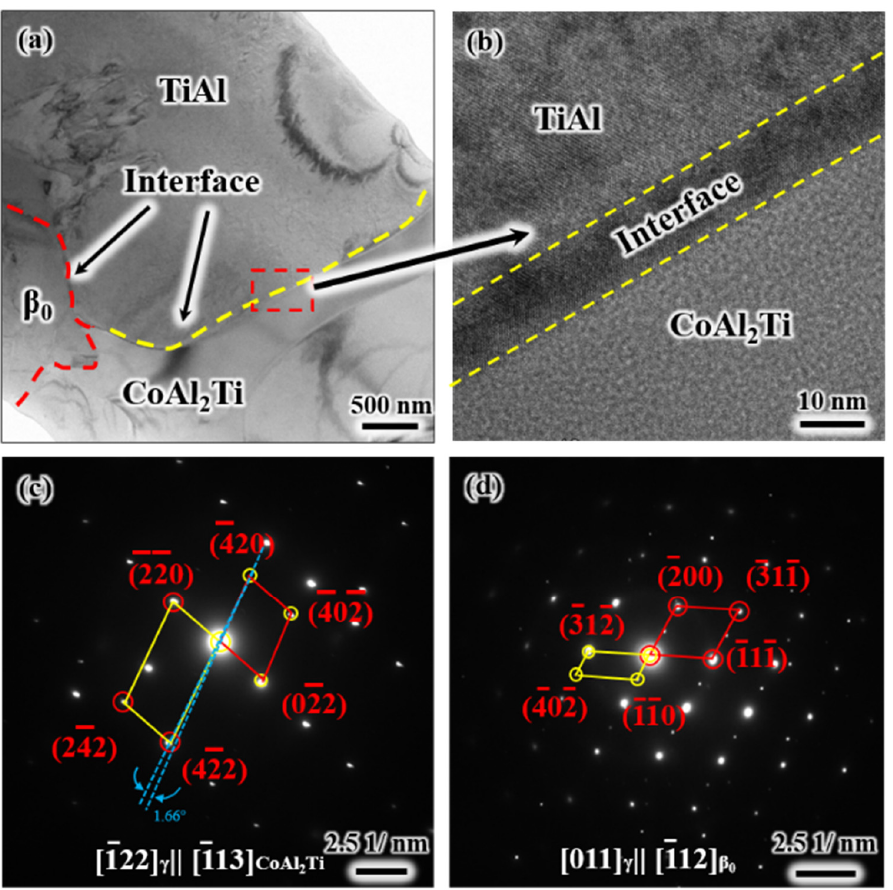
Figure 6. ( a ) Typical bright field image of TiAl, β 0 , CoAl 2 Ti triple phase coexistence. ( b ) An HRTEM of TiAl and CoAl 2 Ti phase interface. ( c , d ) The SADE of γ and CoAl 2 Ti interface and γ and β 0 interface, respectively.